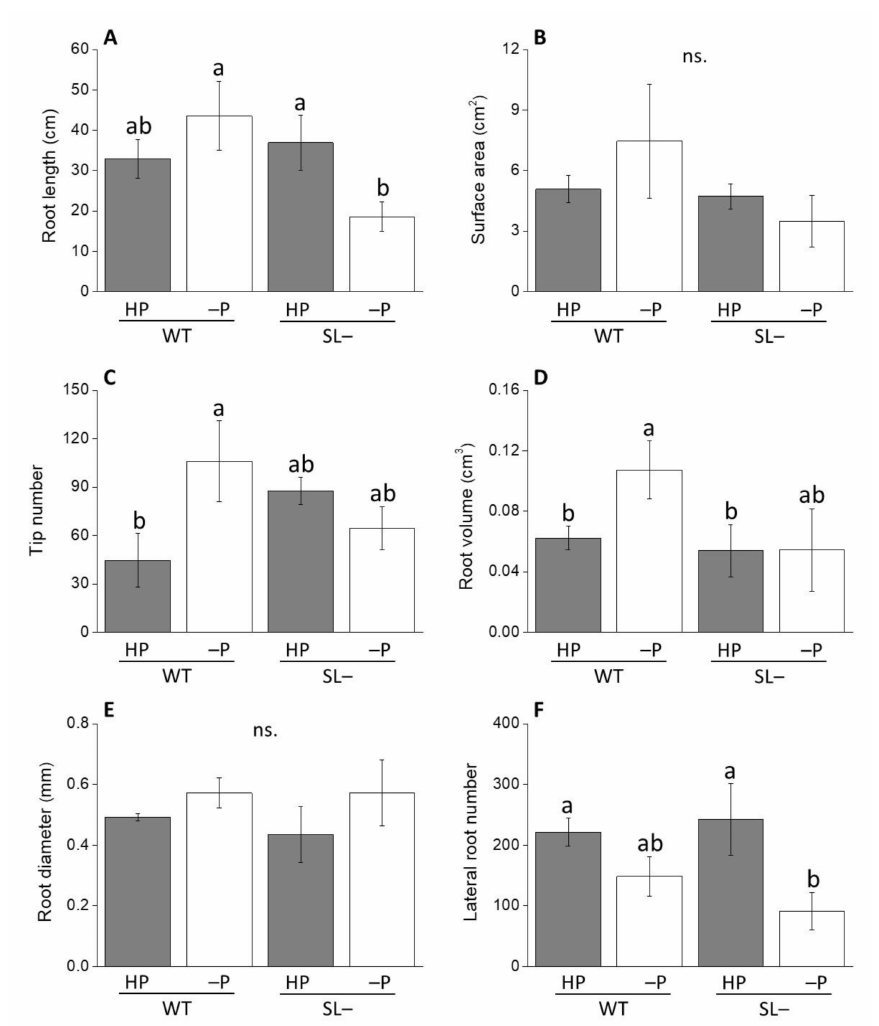
Figure 4. Root growth-associated parameters of wild-type (WT) and strigolactone-depleted plants (SL–) grown for 10 days in MS medium with either high P or low P and further transferred for one week to MS medium containing either high P (HP) or no P (–P), respectively. ( A ) Root length; ( B ) surface area; ( C ) tip number; ( D ) root volume; ( E ) root diameter; ( F ) lateral root number. Data represent the means of 3 measurements per treatment ( ± SE) obtained via WinRHIZO. Di ff erent letters above bars indicate significant di ff erences between treatments ( p ≤